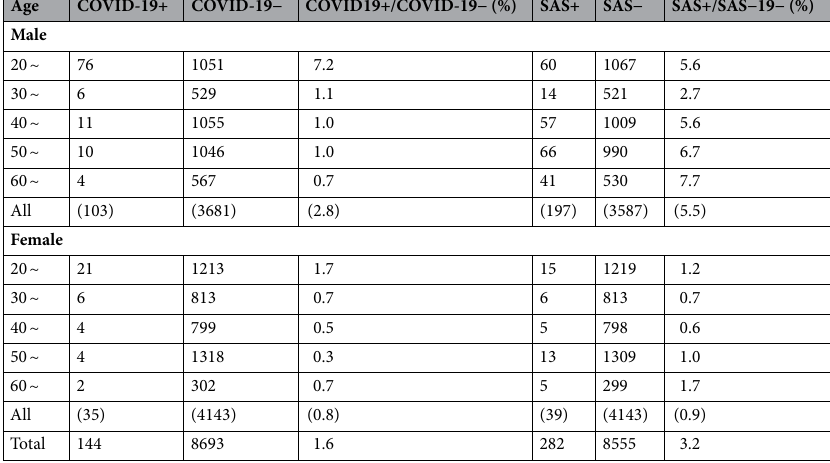
Table 1. Component ratio for the participants for the analysis (n = 8837).